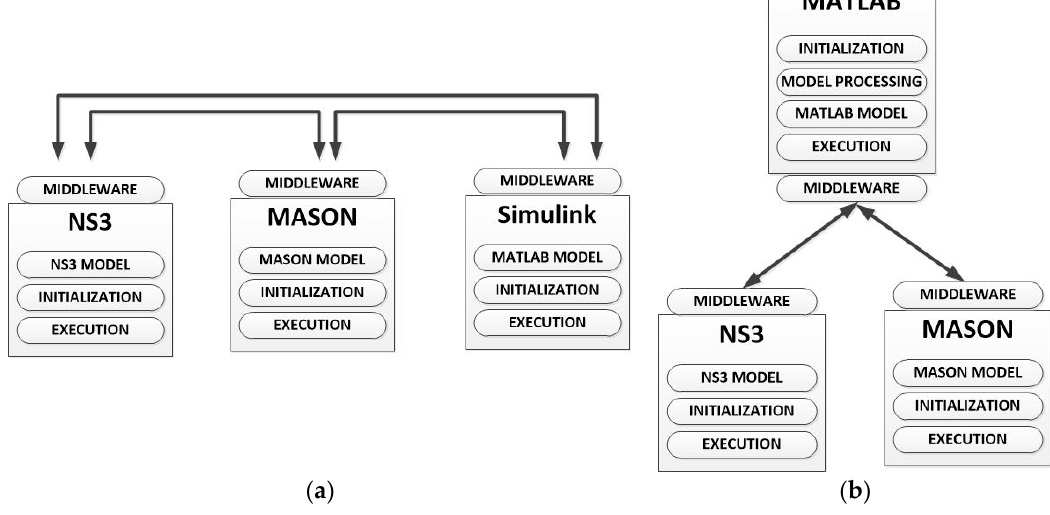
Figure 14. Secondary (auxiliary) co-simulators architecture. ( a ) simulator#1. ( b ) simulator#2.